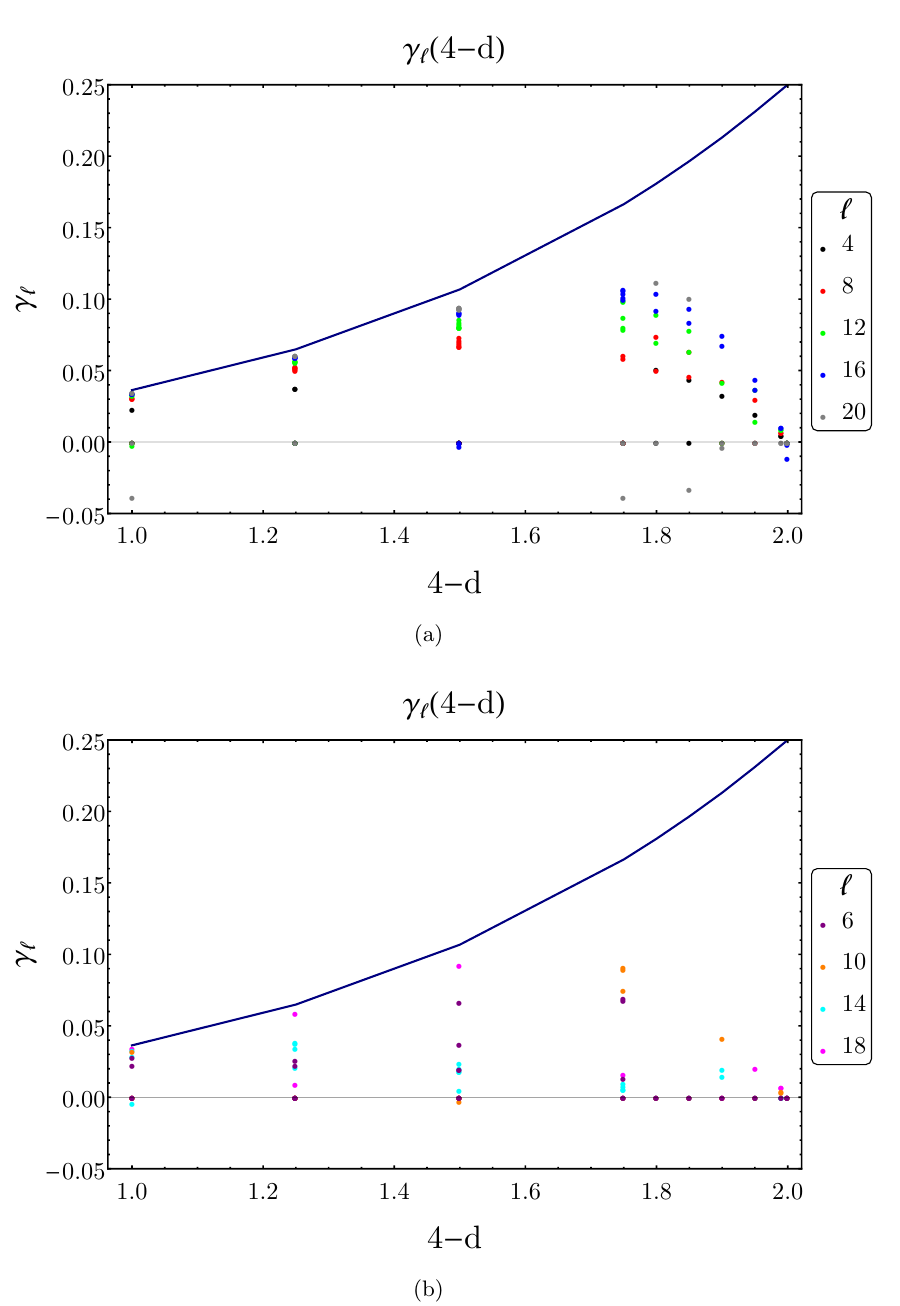
Figure 13 . Dimension dependence of anomalous dimensions (cid:13) ‘ (4 (cid:0) d ): for the ‘ values divided in two sets as given by the color tables. The blue curve shows the large ‘ asymptotic value equal to 2 (cid:13) (cid:27) (4 (cid:0) d